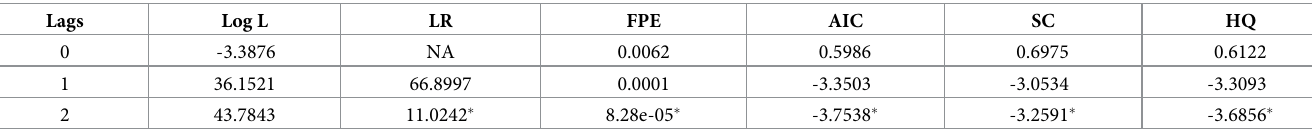
Table 8. Results of lag selection of external R&D and S&T output VAR models with different criterions. Lags